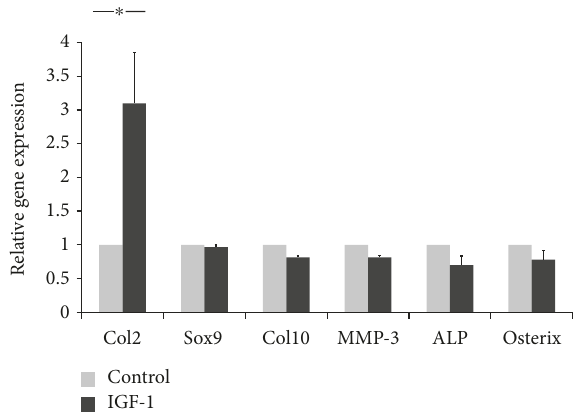
Figure 4: Speci fi c gene expression levels in MSCs under chondrogenic conditions. Gene expression analyses of human synovial MSCs overexpressing IGF-1 after induction of chondrogenic di ff erentiation were performed using real-time RT- PCR. The MSCs were transduced with a pLVSIN-IRES-ZsGreen1 (control; left) or the pLVSIN-IRES-IGF-1 ZsGreen vector (IGF-1; right) and cultured in a chondrogenic di ff erentiation medium for 14 days. The values for each gene were normalized to the GAPDH house keeping gene levels used as the internal control. Ct values were generated for each target gene. ∗ Statistically signi fi cant compared with control values ( p < 0 05 ). GAPDH: glyceraldehyde- 3-phosphate dehydrogenase. Col2 (type II collagen alpha1) and Sox9 were assessed as chondrogenic markers. Col10 (type X collagen) and MMP-13 (matrix metalloproteinase 13) were assessed as hypertrophic chondrocyte markers. ALP (alkaline phosphatase) and Osterix were assessed as osteogenic